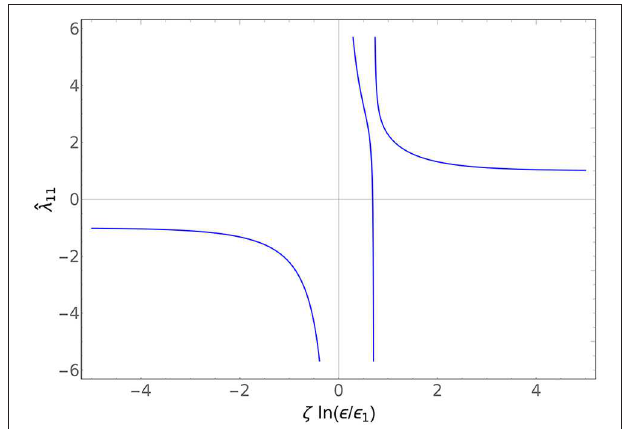
y 2 ζ 2 , y 1 1, and = = = + 0, this reduces to the →